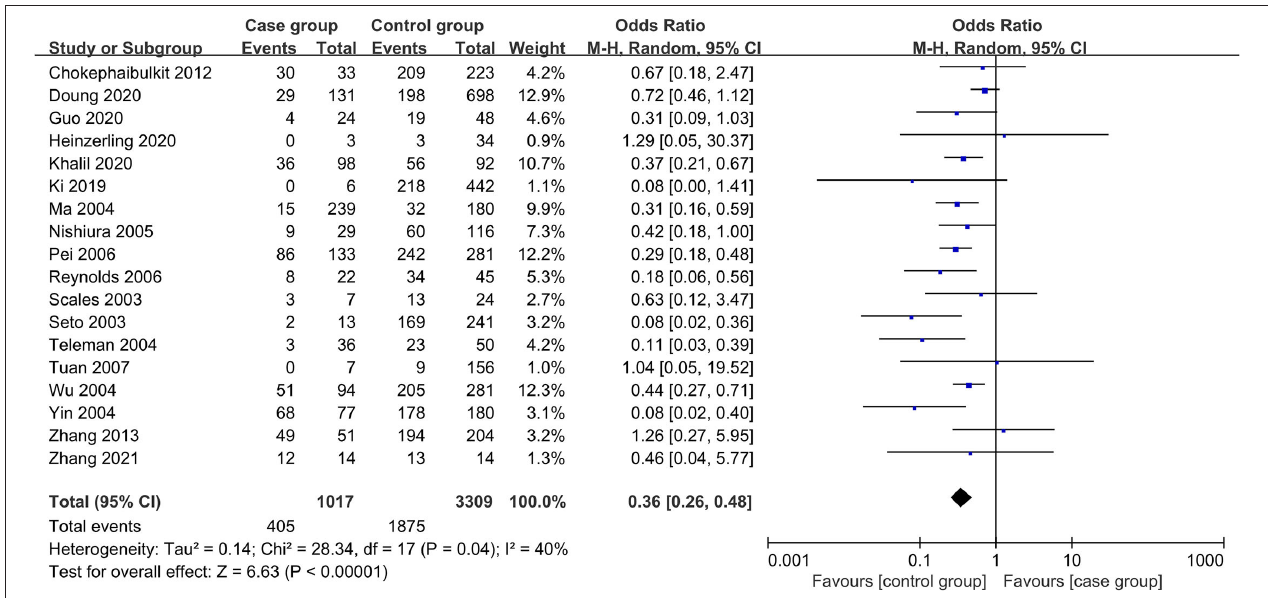
FIGURE 2 | Forest plot of meta-analysis of case-control